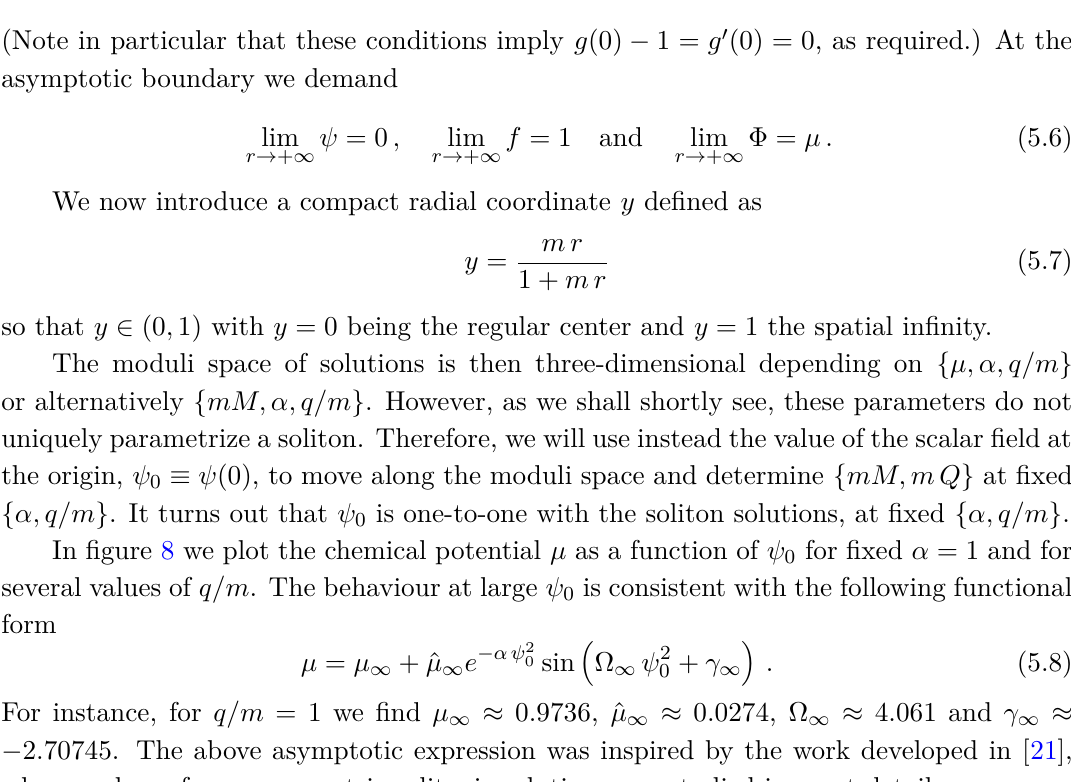
Figure 8 . Chemical potential µ of the solitons as a function of ψ 0 at fixed α = 1 . The legend shows curves with different values of q/m